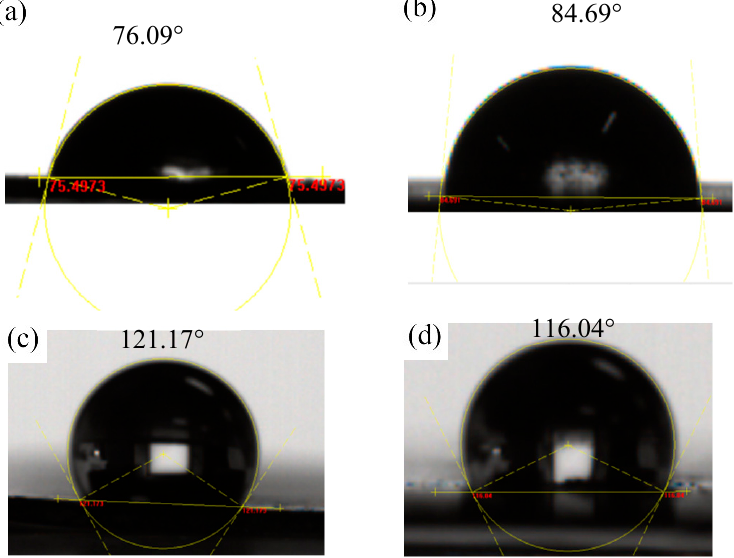
Figure 9. Contact angle of composite coatings after potentiostatic polarization ( a ) bare Ti; ( b ) carbon coating; ( c ) carbon-PTFE/GS coating; ( d ) carbon-PTFE/GS-CNT coating.